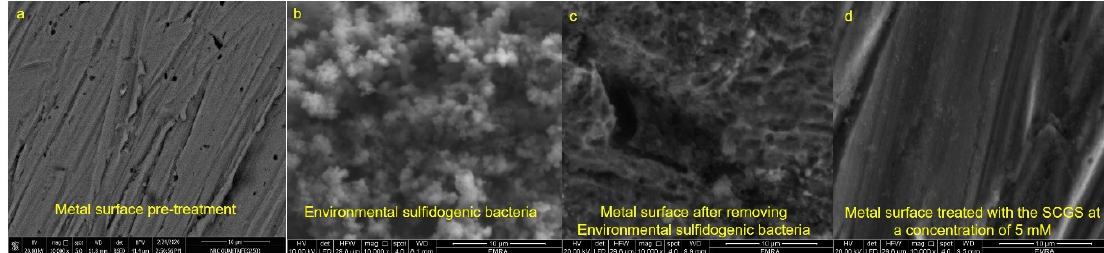
Figure 5. SEM images ( a ) the cleaned metal surface, ( b ) The sulfidogenic biofilm, ( c ) the metal surface (at a salinity of 5.49% NaCl) after removing the biofilm, and ( d ) the environmental sulfidogenic bacteria inoculated with 5 mM SCGS. Scale bar = 10 µm.